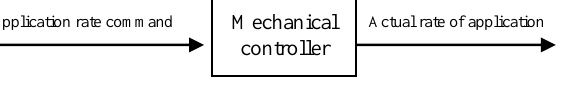
Figure 1 - Open loop control system.